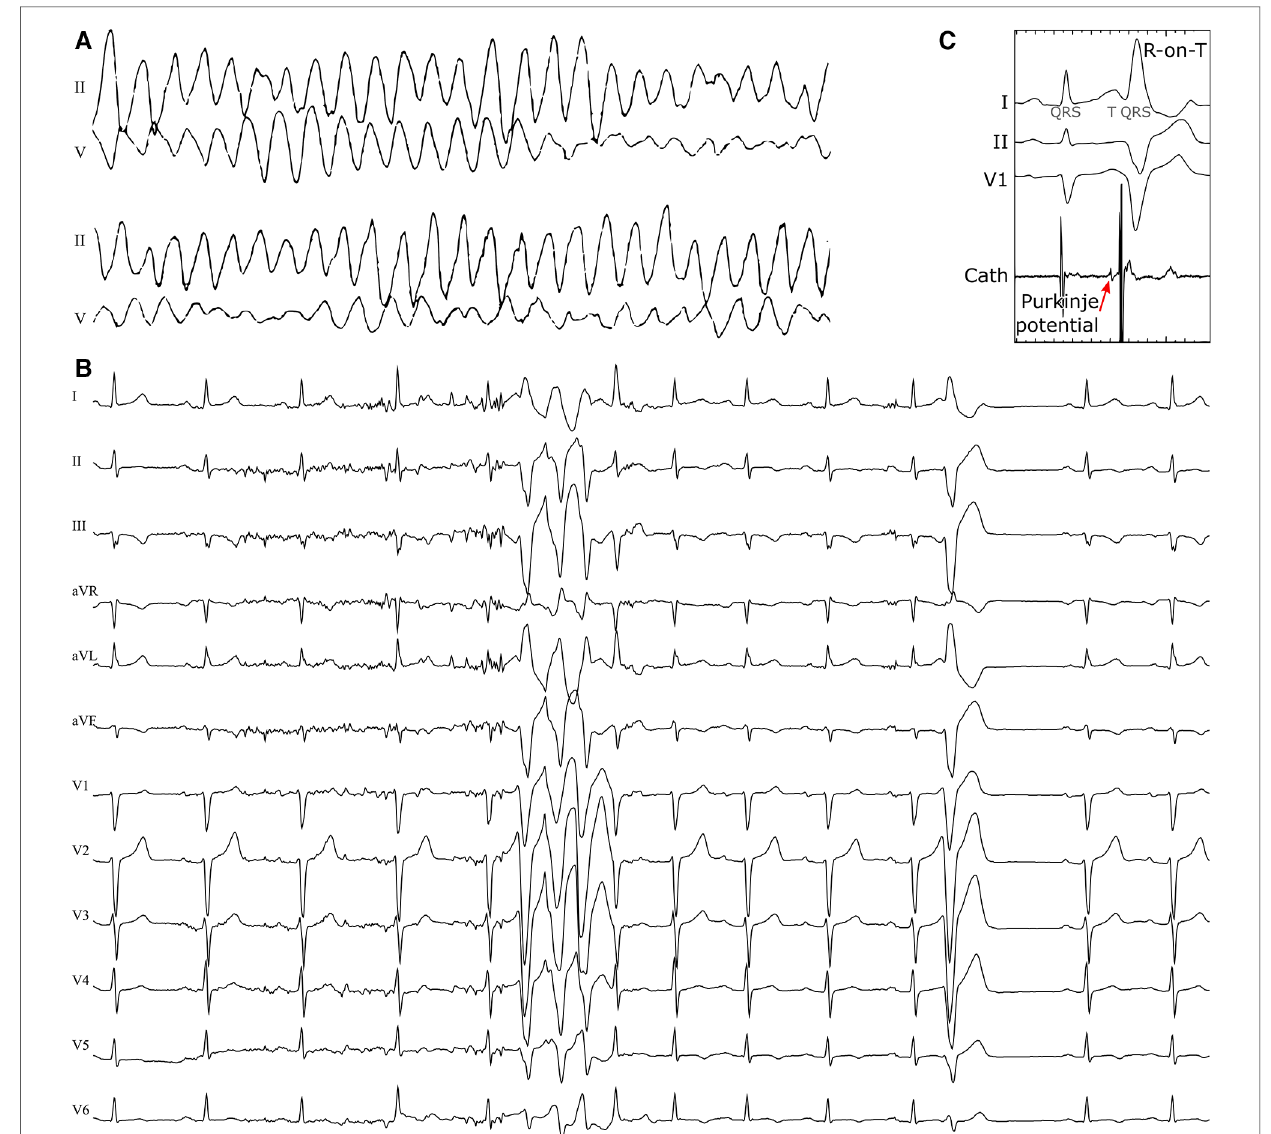
FIGURE 2 Polymorphic ventricular tachycardia at presentation ( A ), short-coupled extrasystoles from the right-ventricular moderator-band region with an R-on-T morphology and runs of NSVT ( B ) in a 47-year old female patient with no previous cardiac history. An invasive electrophysiology study highlighted Purkinje- fi ber activity preceding the R-on-T premature beats ( C